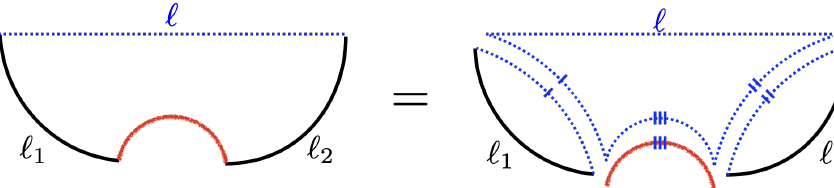
Figure 18. The calculation of the connected component of the Wheeler-de Witt function can be decomposed into an integral over these intermediate